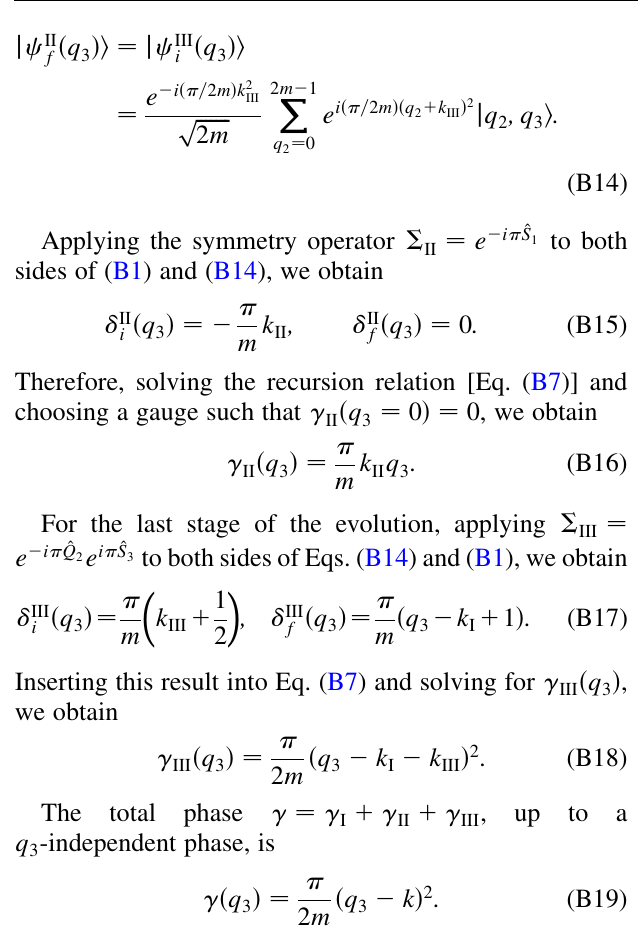
FIG. 5. Braiding paths in Hamiltonian space. (a) Path P which we compute the braiding adiabatic evolution operator explicitly. (b) A different path P at the intermediate stages are assumed to be adiabatically con- nectable to those of P which each intermediate Hamiltonian of P corresponding Hamiltonian of P